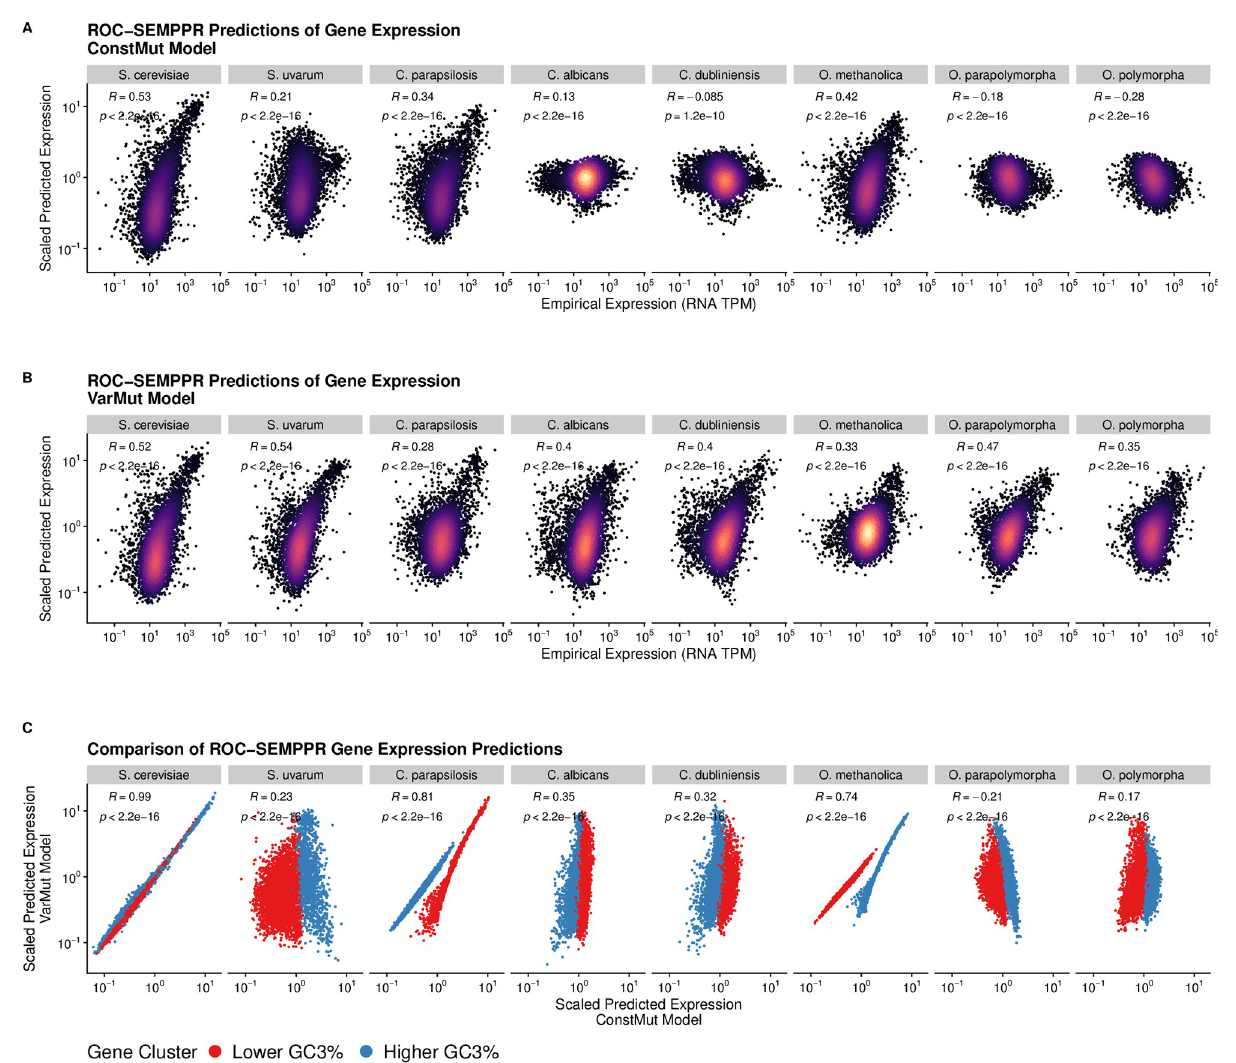
Fig 2. Effects of allowing for non-adaptive nucleotide biases to vary across genes on predictions of gene expression. (A) Correlation between empirical and predicted gene expression values for each gene when mutation bias parameters are shared across clusters (ConstMut Model), as in Fig 1. (B) Correlation between empirical and predicted gene expression values when mutation bias parameters are allowed to vary across clusters (VarMut model). (C) Comparison of predicted gene expression between the ConstMut and VarMut models.